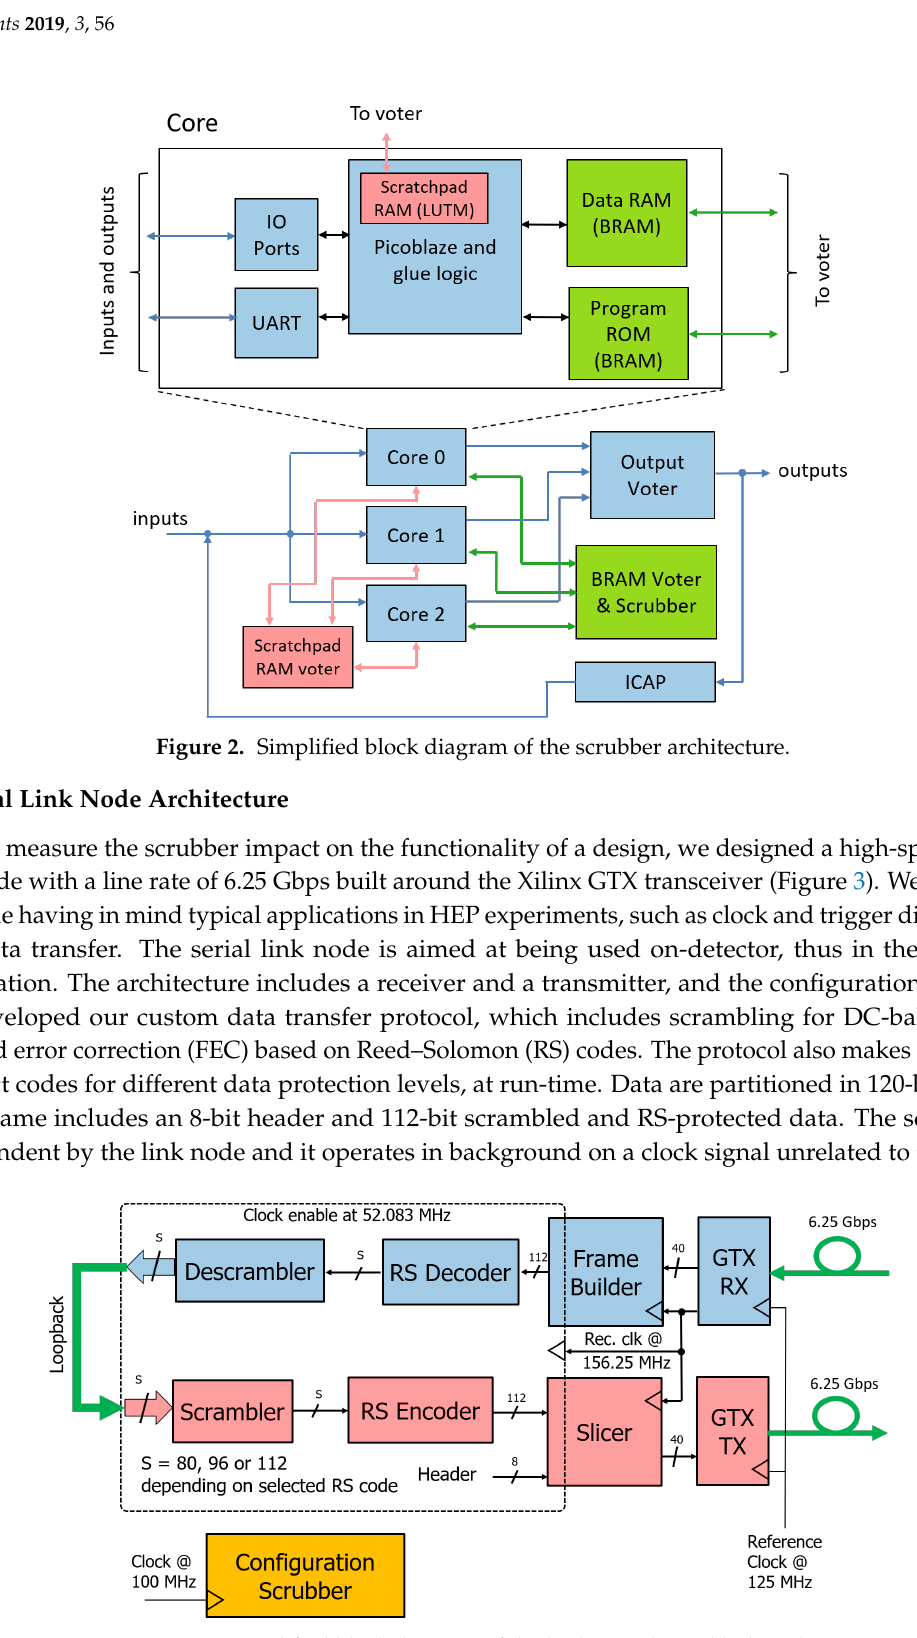
Figure 3. Simplified block diagram of the high-speed serial link